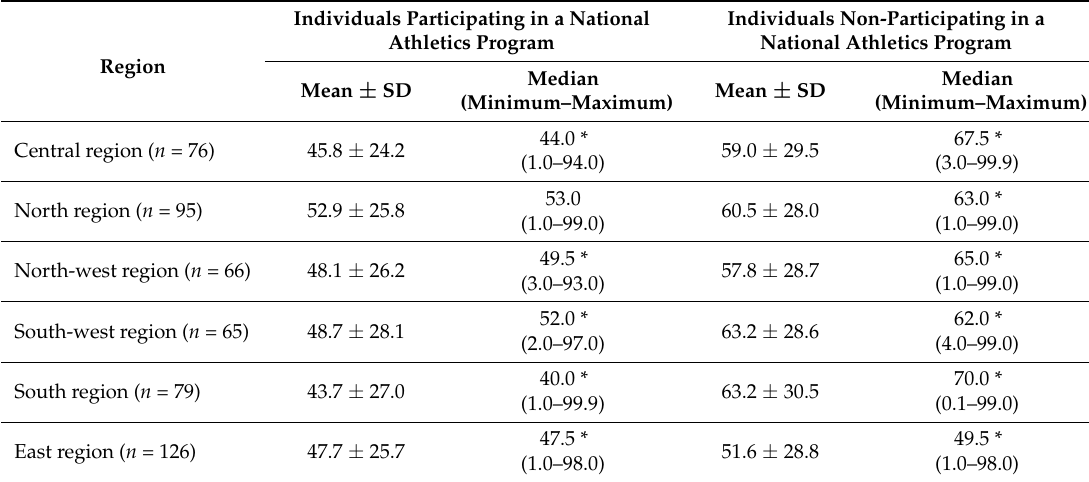
Table 1. The BMI percentile of adolescents participating in a national athletics program and pair-matched control group of adolescents stratified by